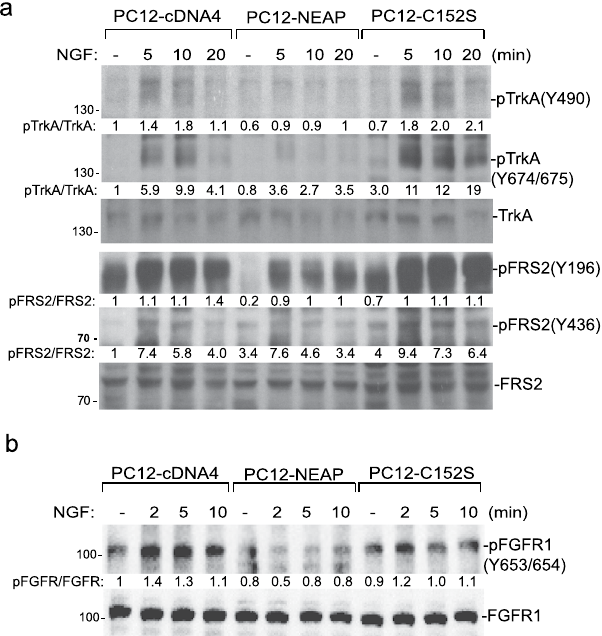
Figure 2. NEAP suppresses NGF-induced TrkA and FGFR1 phosphorylation. PC12-cDNA4, NEAP, or NEAP- C152S cells were treated with NGF (50 ng/ml) and the cells were collected at the indicated time points. ( a ) Levels of TrkA, pTrkA, FRS2, and pFRS2 were examined by immune-blotting assays using specific antibodies as indicated. ( b ) Levels of FGFR1 and pFGFR1 were examined by immune-blotting assays. The phospho- protein/protein ratio in the untreated PC12-cDNA4 cells was designed as 1. The results from two independent experiments were presented in Supplementary